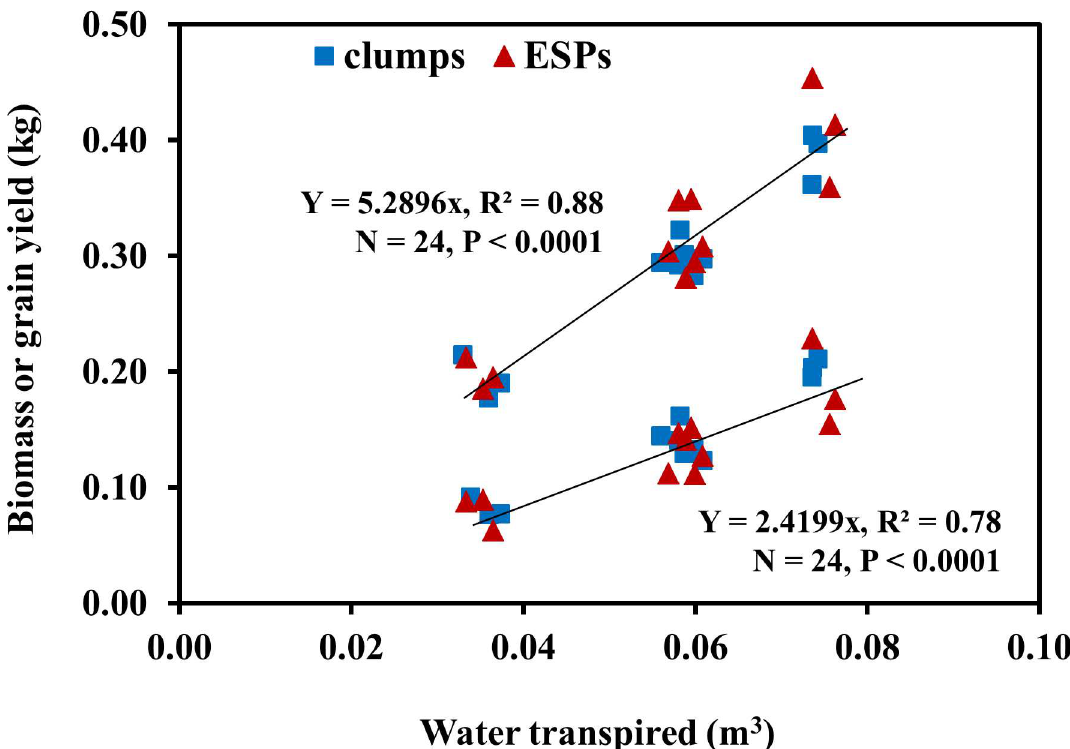
Fig 4. Linear regression between water transpired, and aboveground biomass or grain yield for plants grown with lid covered surfacetreatments in 2013 and 2014. TEb: biomass transpiration efficiency; TEg: grain transpiration efficiency (N =